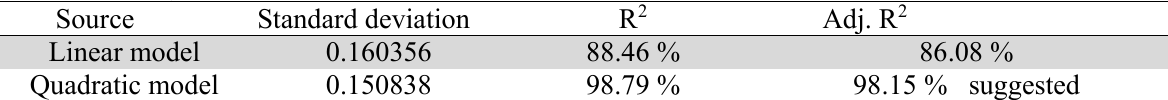
Model summary statistics for Ra